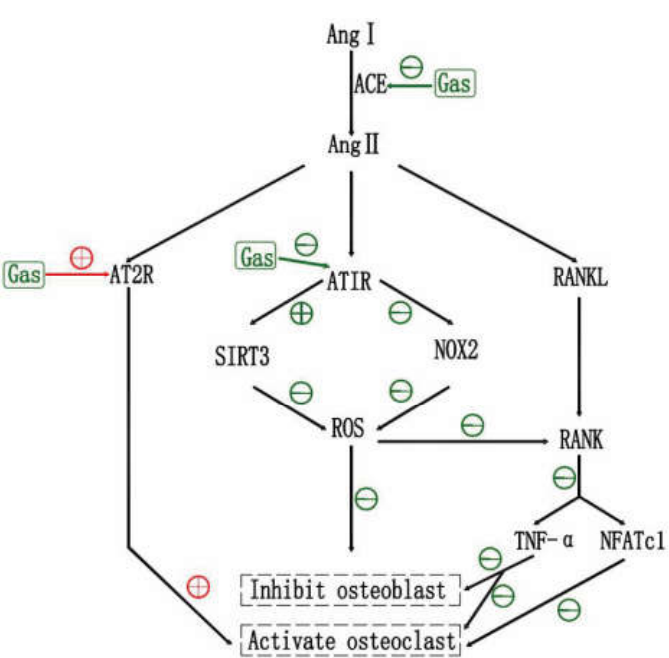
Figure 4. The potential mechanism of gastrodin against osteoporosis via RAS. Gastrodin partially blocks RAS by inhibiting the activation of ACE and AT1R, then decreasing the NOX-2 expression and increasing the SIRT3 expression, eventually reducing ROS content. As a result, RANLKL induced osteoclast differentiation is inhibited and oxidative damage of osteoblast is alleviated. But the increased expression of AT2R induced by gastrodin promotes osteoclast differentiation.